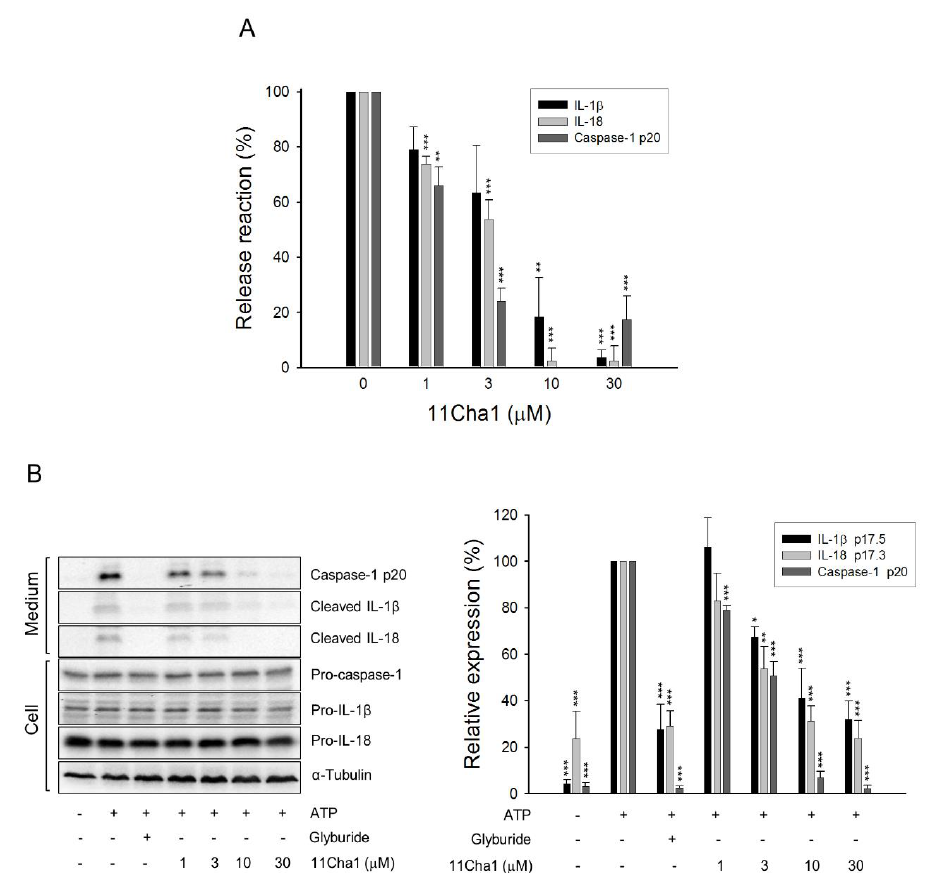
Figure 2. Effects of 11Cha1 on the release reaction and protein expressions of caspase-1 and cytokines. THP-1 cells were seeded and differentiated by 50 nM PMA for 48 h and then primed with 1 μg/mL LPS for 4 h. The cells were pre-treated with or without the indicated agent (200 µM glyburide as the positive control) for 30 min before a two-hour exposure to 5 mM ATP. After treatment, the concentrations ( A ) and protein expressions ( B ) of p20 caspase-1 subunit and cytokines in the medium were determined. Data are expressed as mean±SEM of three independent experiments. One-way ANOVA by Newman Keuls post hoc test was used. * P < 0.05, ** P < 0.01, and *** P < 0.001 compared with ATP-treated control. The analyses of P (ANOVA) indicated P < 0.001 in all tests.